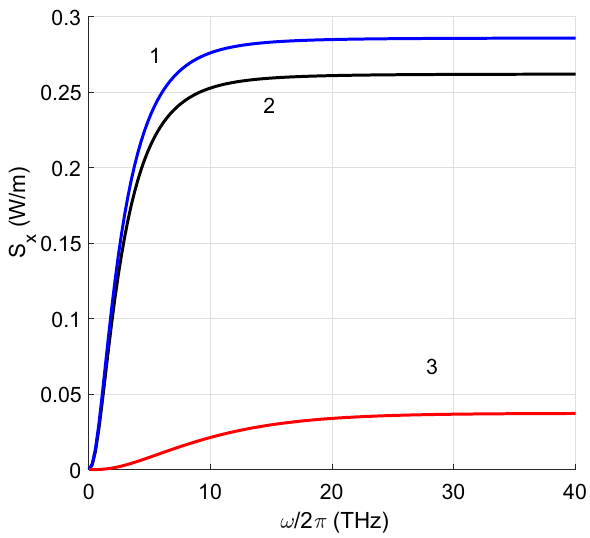
Figure 3. Radiative heat transfer per unit length S x versus frequency calculated for zigzag CNTs with m 1 m 2 15 (blue curve 1) and armchair CNTs with m 1 = = for the case of absence of